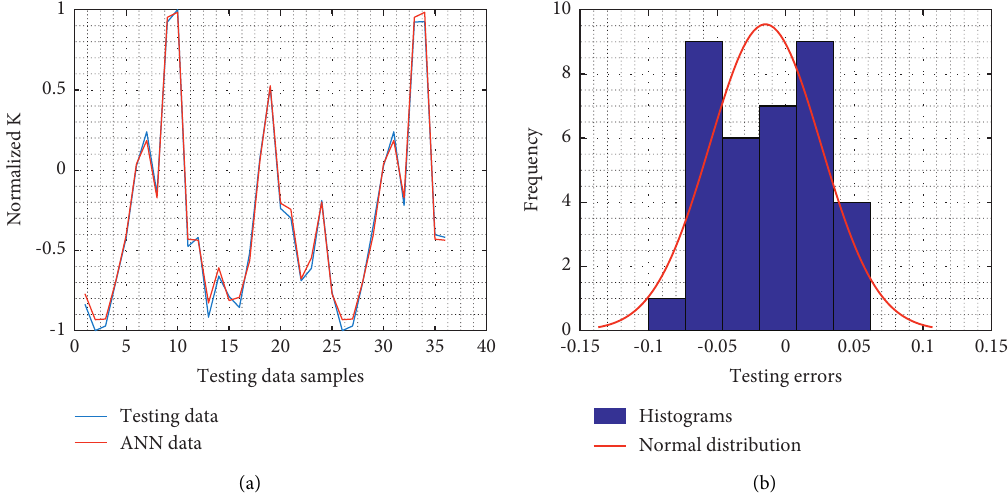
Figure 9: Testing data